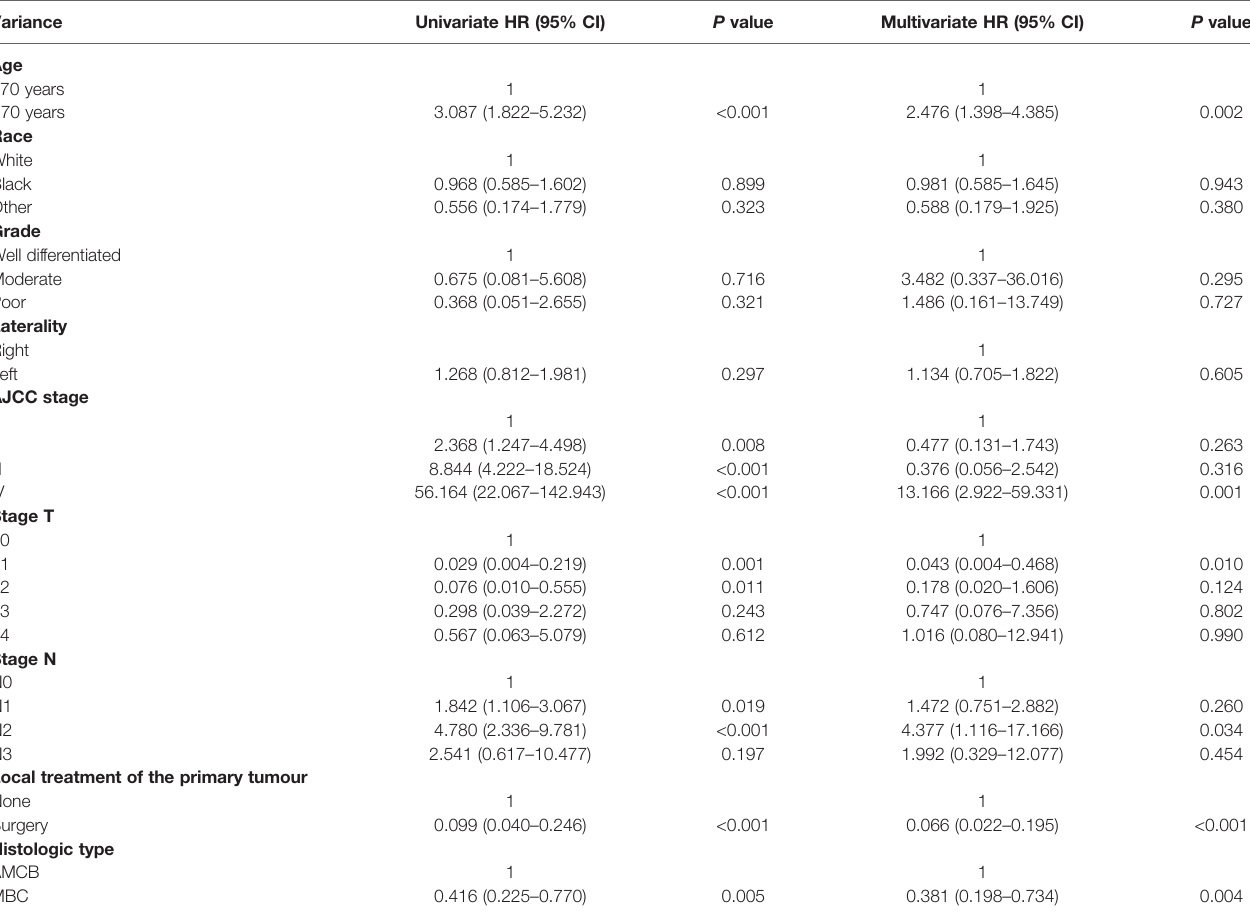
TABLE 6 | Univariate and multivariate Cox proportional hazard analyses of the association of clinical characteristics with overall survival rates in HR ( − ) patients with AMCB and MBC.